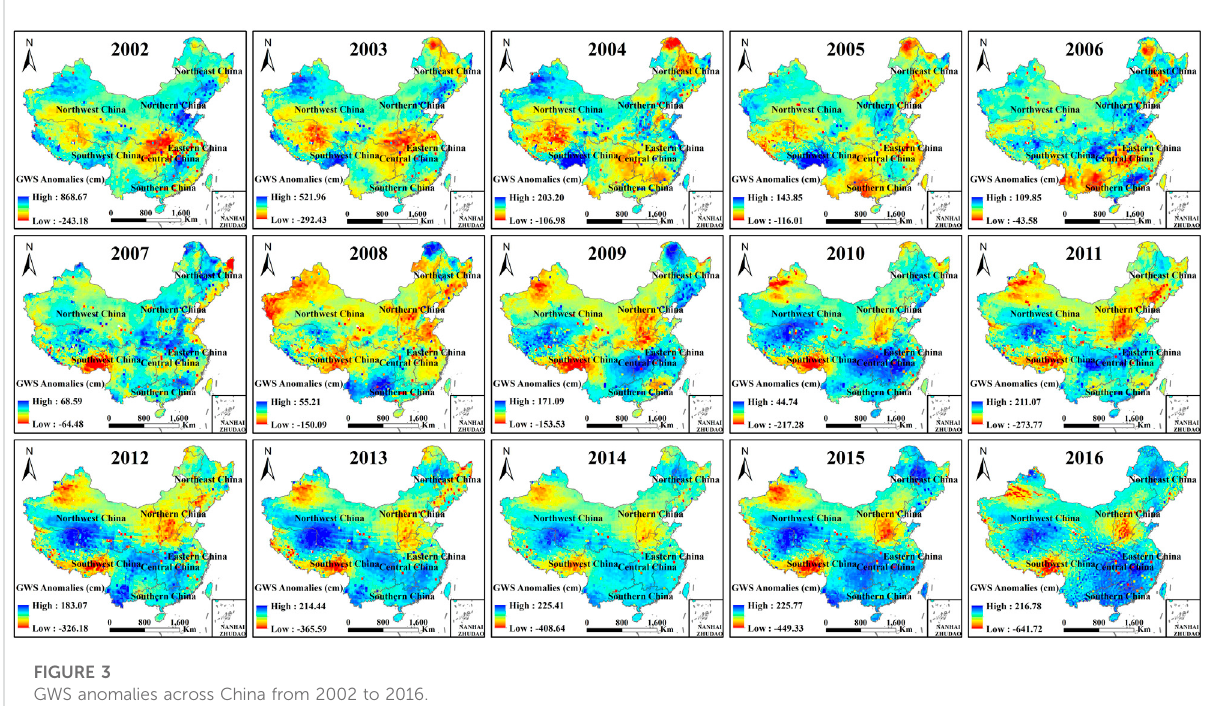
FIGURE 3 GWS anomalies across China from 2002 to 2016.